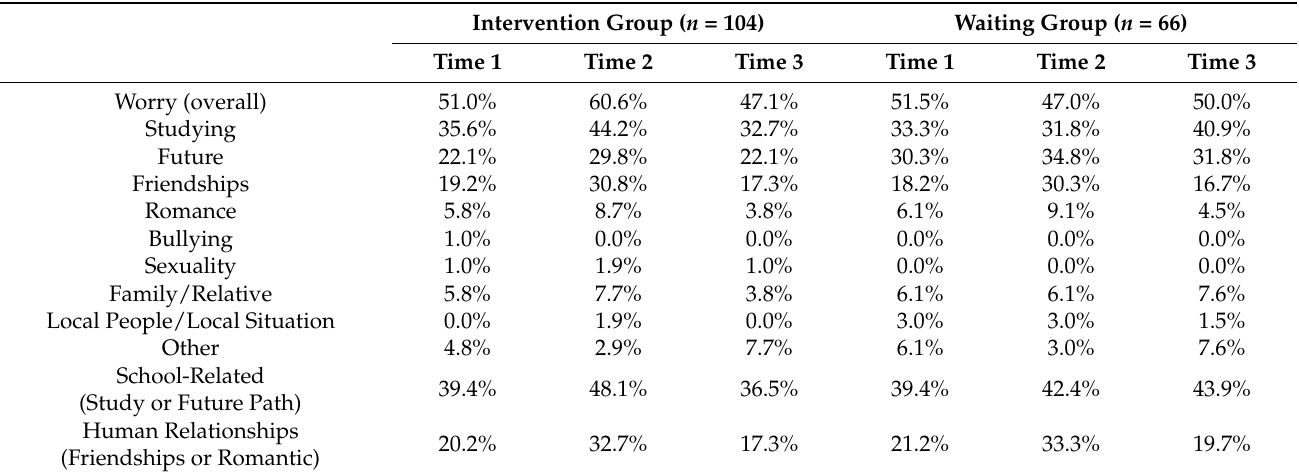
Table 2. Ratio of “presence of worries” in each